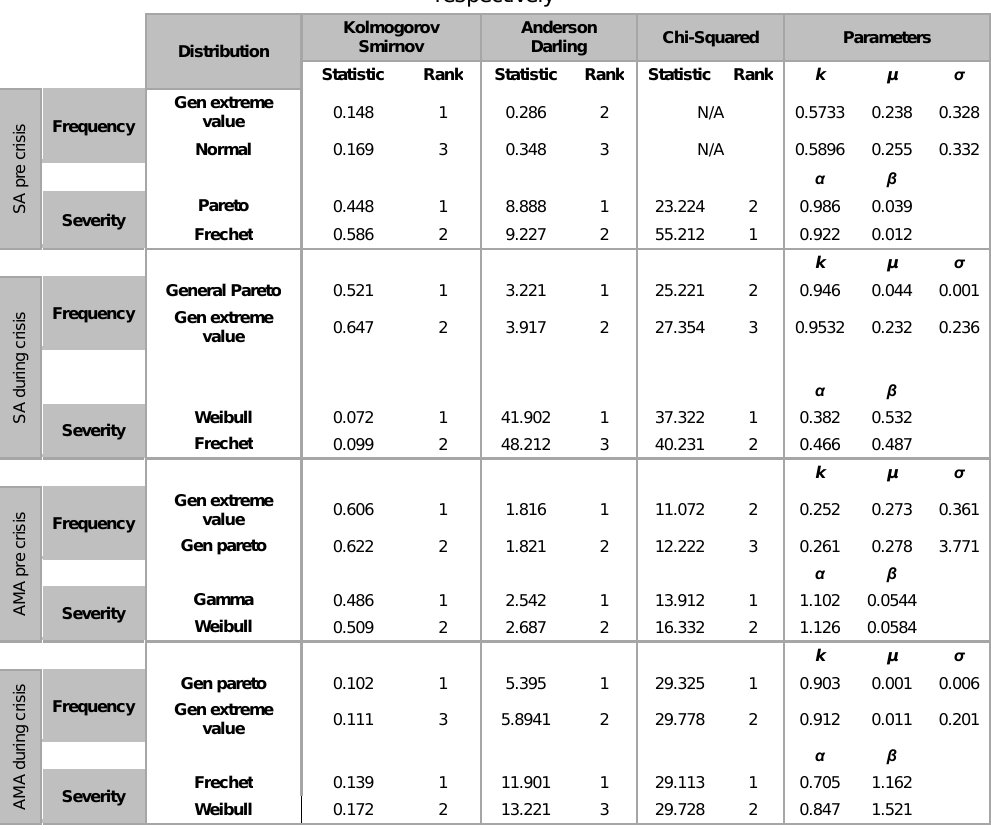
Summary statistics and goodness of fit test results of the frequency and severity